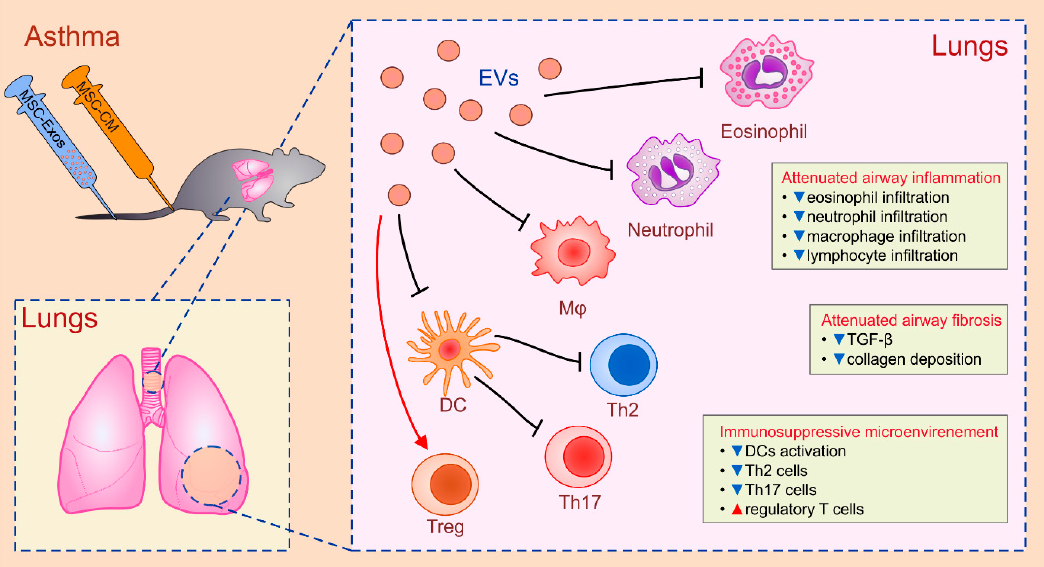
Figure 1. Molecular mechanisms responsible for beneficial e ff ects of MSC-derived secretome in asthma. Administration of MSC-sourced secretome significantly reduced influx of circulating eosinophils, neutrophils, monocytes and lymphocytes in asthmatic lungs resulting in alleviation of on-going inflammation. MSC-CM or MSC-Exos reduced TGF- β production, decreased collagen deposition and attenuated fibrosis in the lungs. Additionally, MSC-derived secretome attenuated antigen-presenting function of DCs and suppressed Th2 and Th17 cell-driven inflammatory response in asthmatic lungs, but increased total number of lung-infiltrated IL-10-producing Tregs which created immunosuppressive microenvironment that allowed better functional recovery of asthmatic